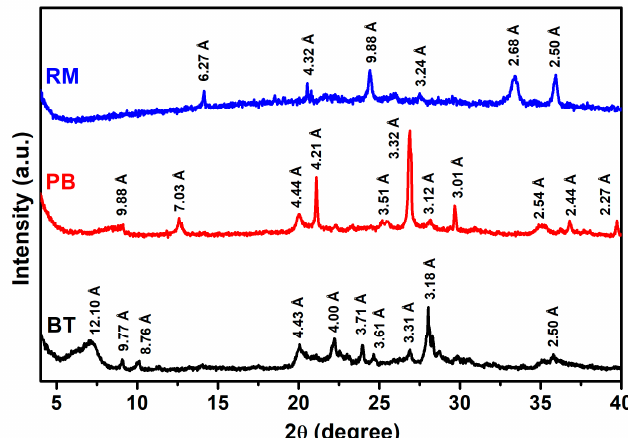
Figure 3. XRD patterns of bentonite purchased from Alfa Aesar (BT), Pakistani bentonite clay (PB), and Turkish red mud (RM) adsorbent.